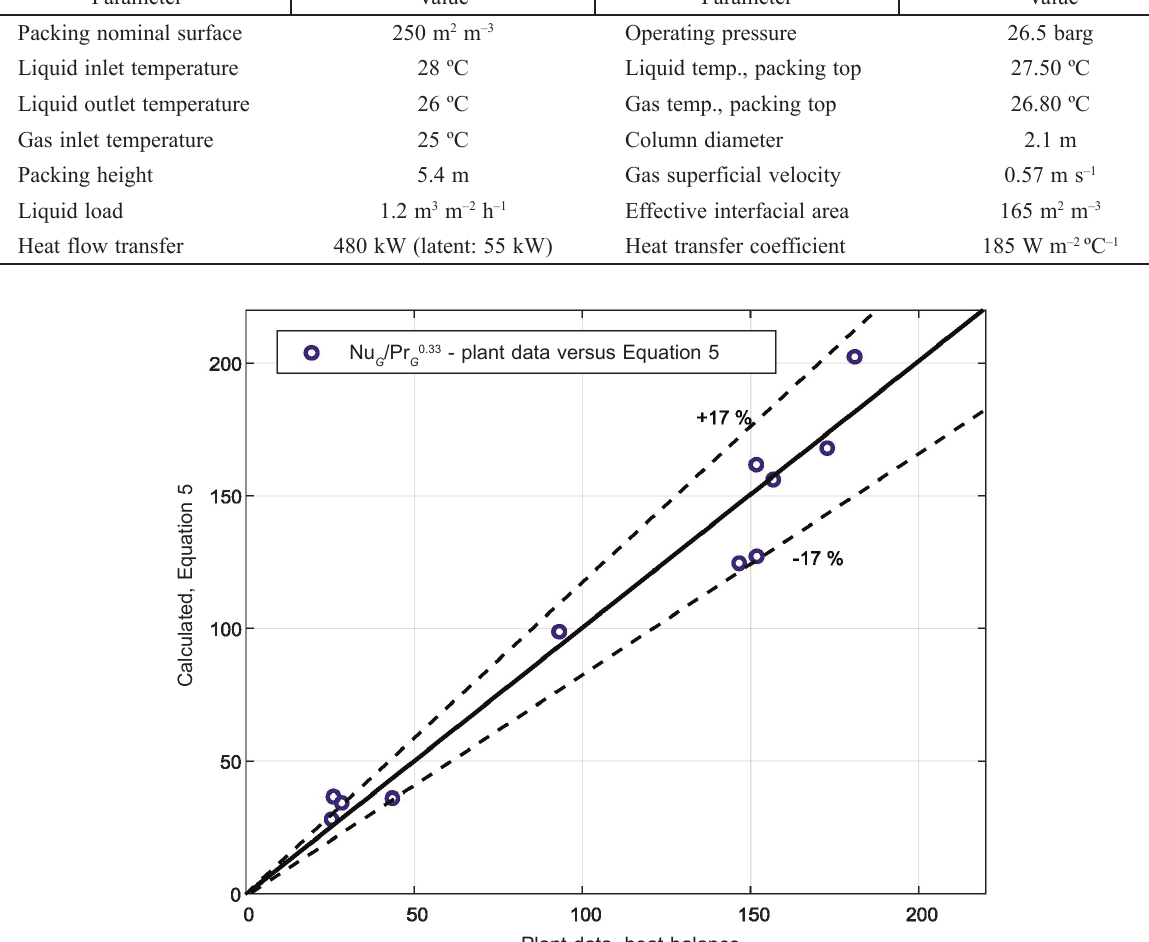
Fig. 4 – Nusselt number (Nu